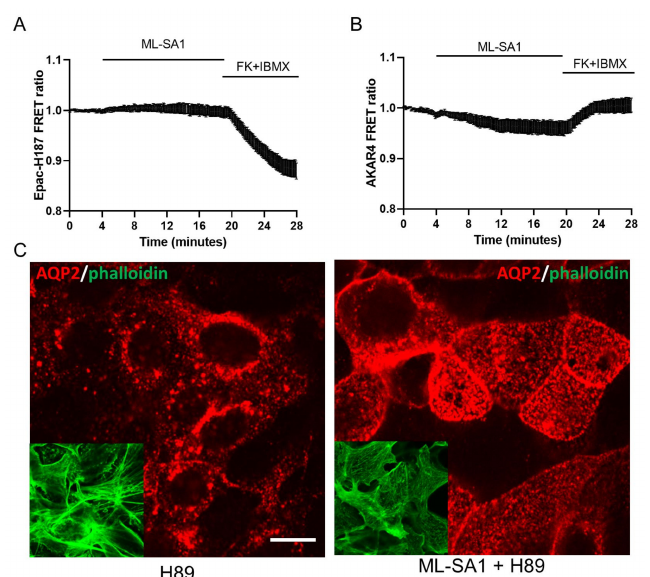
Figure 8. cAMP/PKA pathway is not involved in ML-SA1-induced AQP2 accumulation on the apical membrane of MCD4 cells. ( A ) M1 cells either expressing Epac-H187 ( n = 0/15 responsive cells, m = 4 experiments) or ( B ) AKAR4 ( n = 0/16 responsive cells, m = 4 experiments) were stimulated with 100 µ M ML-SA1 for 15 min. Perfusion with 5 µ M FK+ 500 µ M IBMX was used as positive control for cAMP production and PKA activity, respectively. Graphs show the average ± SEM of cells on a single coverslip, at least 3 independent experiments were performed; ( C ) Cells were treated for 30 min with 10 µ M H89 alone or followed by 100 µ M ML-SA1 for 15 min and stained with an antibody against AQP2 (red) and phalloidin Alexafluor-488 to visualize F-actin (green, inset). Images are representative of 3 independent experiments. Scale bar: 20 µ